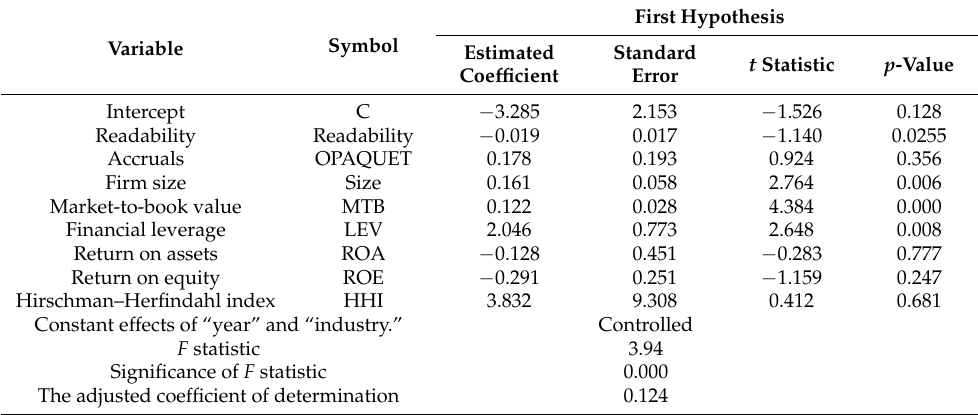
Table 4. Results of the first hypothesis.